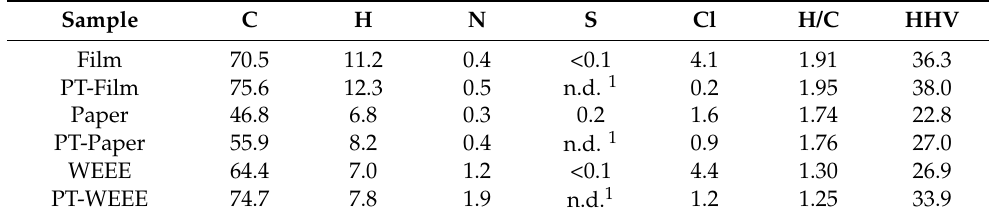
Table 3. Ultimate analysis (wt.%) and HHV (MJ kg − 1 ) of raw and pre-treated waste samples (as received).